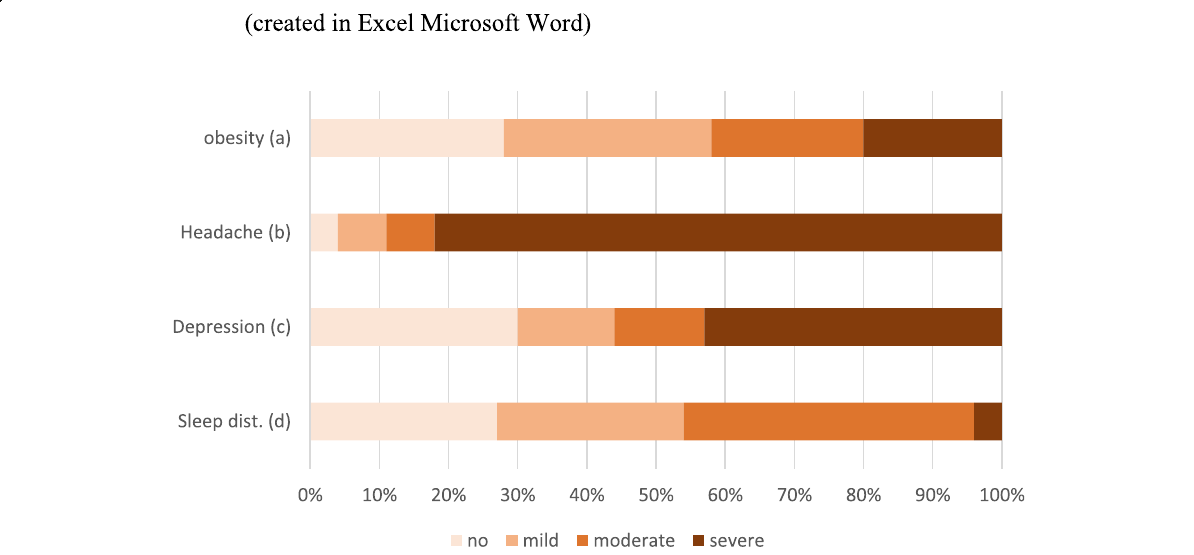
Fig. 1 Patient distribution (%) of obesity (BMI), headache impact (HIT-6), depression (MDI) and sleep disturbances (PROMIS SD). a. BMI < 30: 28 %, BMI 30-34.9: 30 %, BMI 35 – 40: 22 % and BMI ≥ 40: 20 %. b . Headache Impact Test < 50: 4 %, HIT-6 50 – 55: 7 %, HIT-6 56 – 59: 7 % and HIT-6 ≥ 60: 82 %. c . Major Depression Inventory 0 – 20: 30 %, MDI 21 – 25: 14 %, MDI 26 – 30: 13 % and MDI 31 – 50: 43 %. d . PROMIS SD Short form 8a (T-score < 55): 27 %, T-score 55 – 60: 27 %, T-score 60 – 70: 42 % and T-score > 70: 4